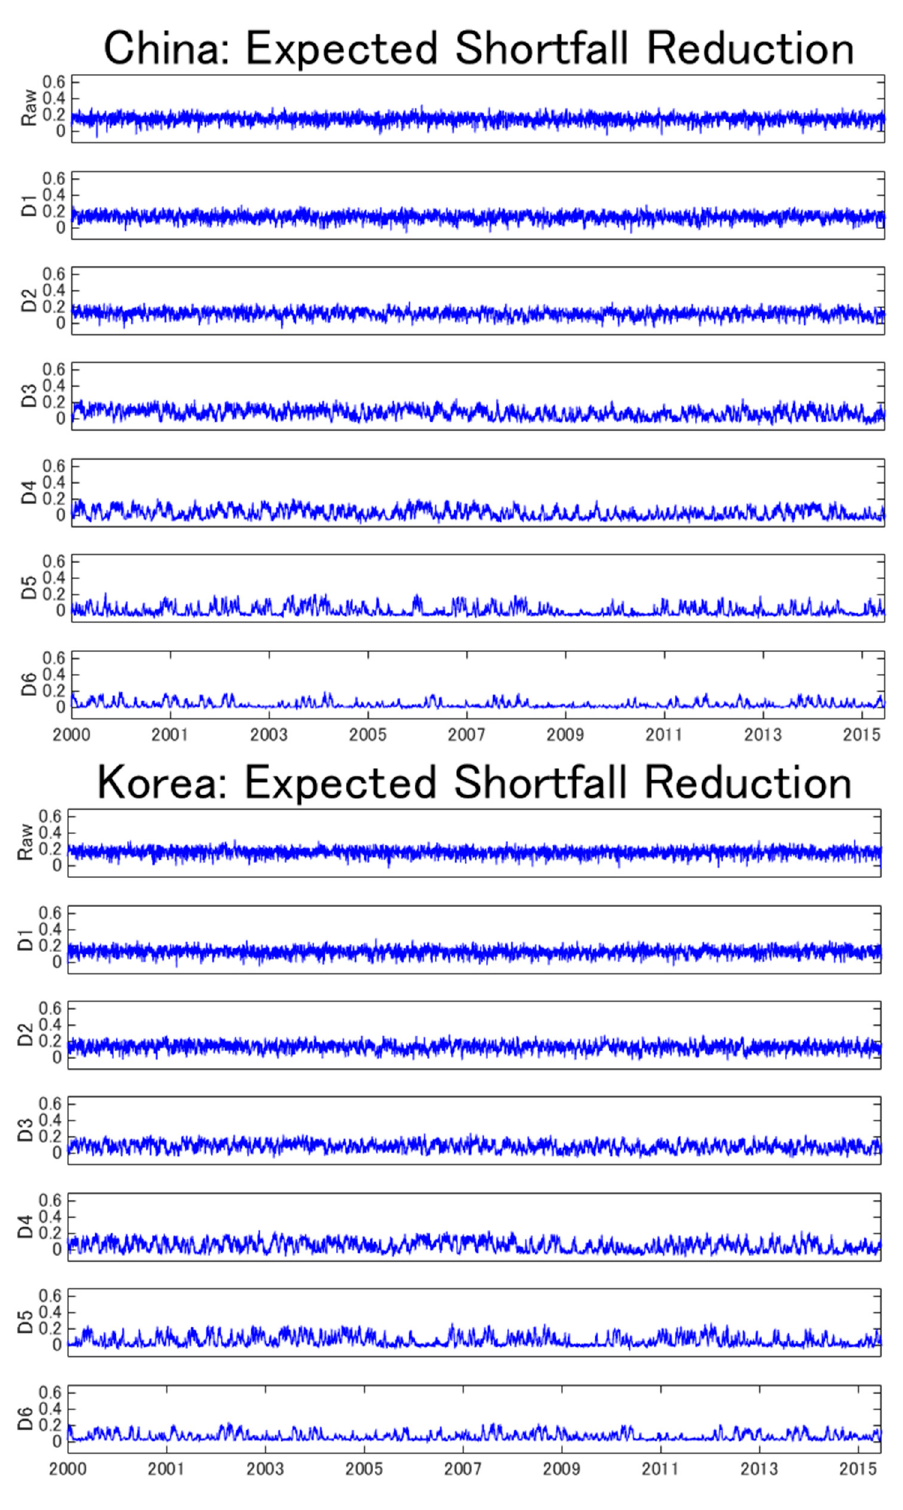
Figure 4. Dynamic portfolio variance and expected shortfall reduction effectiveness for oil-stock portfolios at the multiple time scales.